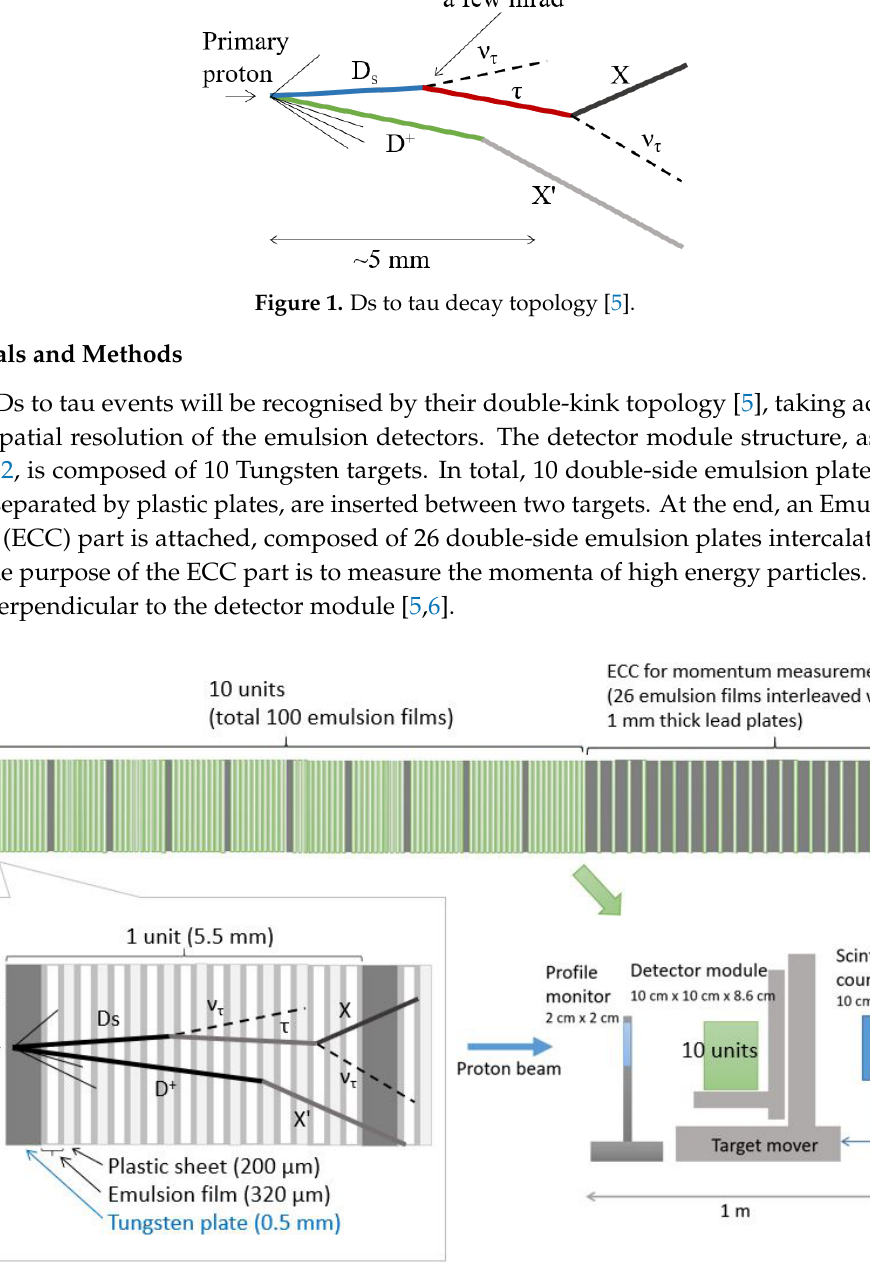
Figure 2. ( Up ) The detector module, consisting on 10 units (1 Tungsten + 10 emulsions + 9 plastic plates) and the ECC; ( left ) expected Ds to tau decay topology into one module; ( right ) the target mover together with the telescopes. This figure is form